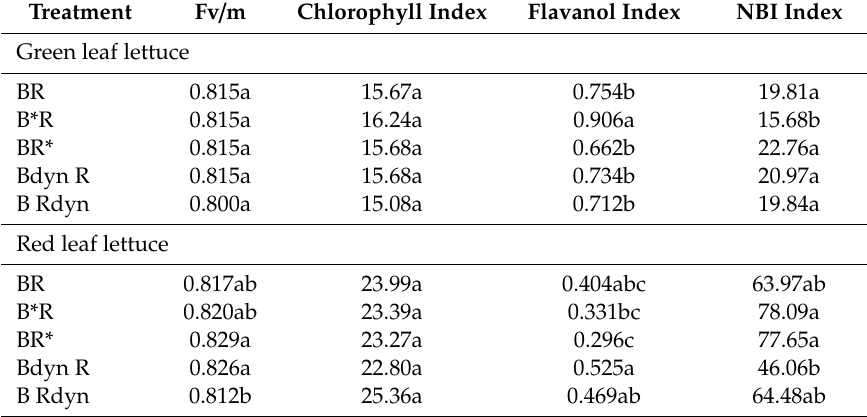
B Rdyn Table 2. Non-destructive measurement parameters in red and green lettuce leaves, illuminated with constant and dynamic fluxes of red 662 nm and blue 452 nm light. Fv/m—quantum efficiency of PSII; NBI—nitrogen balance index. Different letters indicate statistically significant differences between means according to the Duncan’s multiple range test at the confidence level p = 0.05.